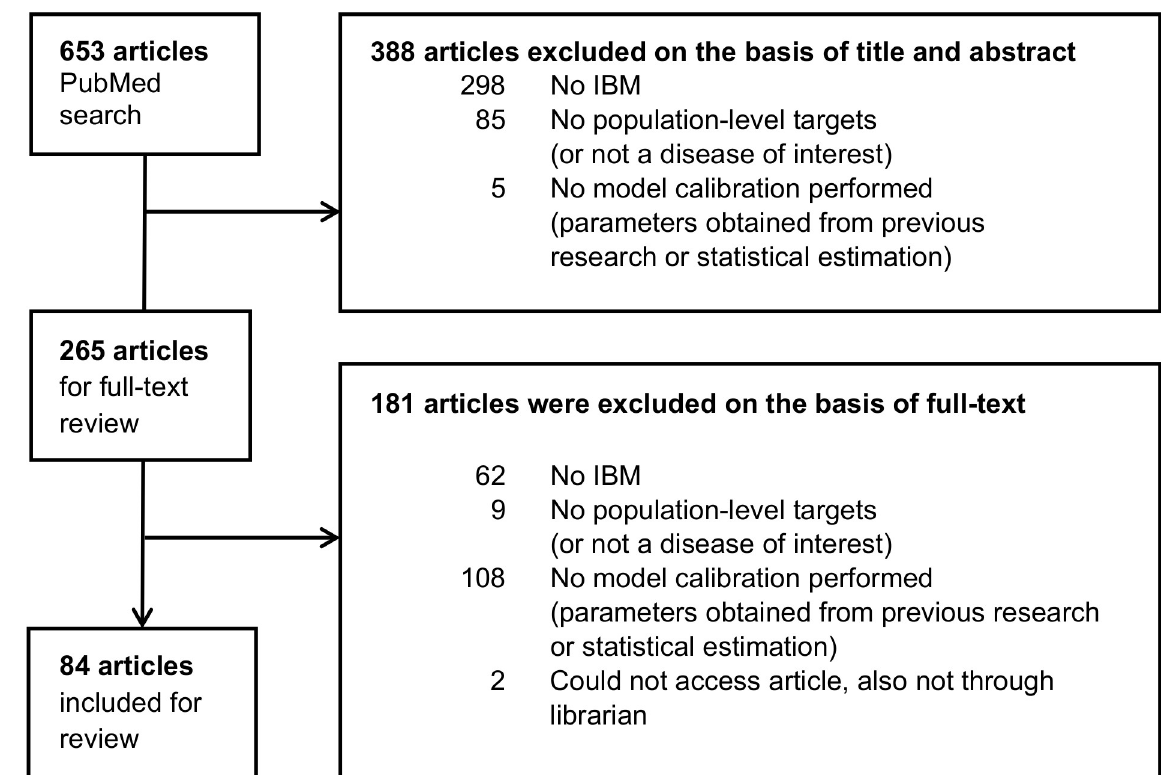
Fig 1. PRISMA flow diagram detailing the selection process of articles included in the review.